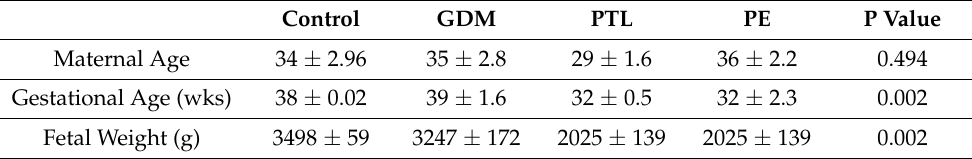
Table 1. Demographical Data from collected placental samples. Parameters between control and disease placental groups ( n = 6) were analyzed for statistical significance ( p < 0.05) using the Kruskal- Wallis test.